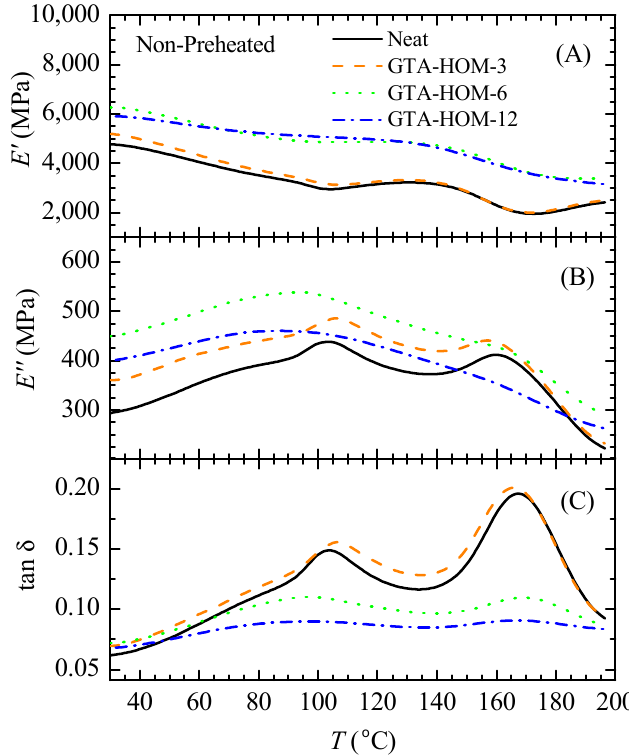
Figure A1. The plots of ( A ) storage modulus, ( B ) loss modulus, and ( C ) tan δ against temperature of non-preheated 3, 6, and 12% GTA-HOM films and a neat chitosan film. Processes 2019 , 7 , x FOR PEER REVIEW